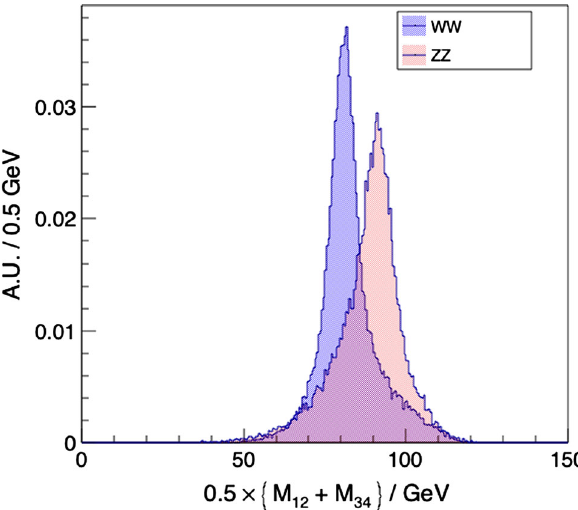
Fig. 6 The RecoJet level distribution of M 12 versus M 34